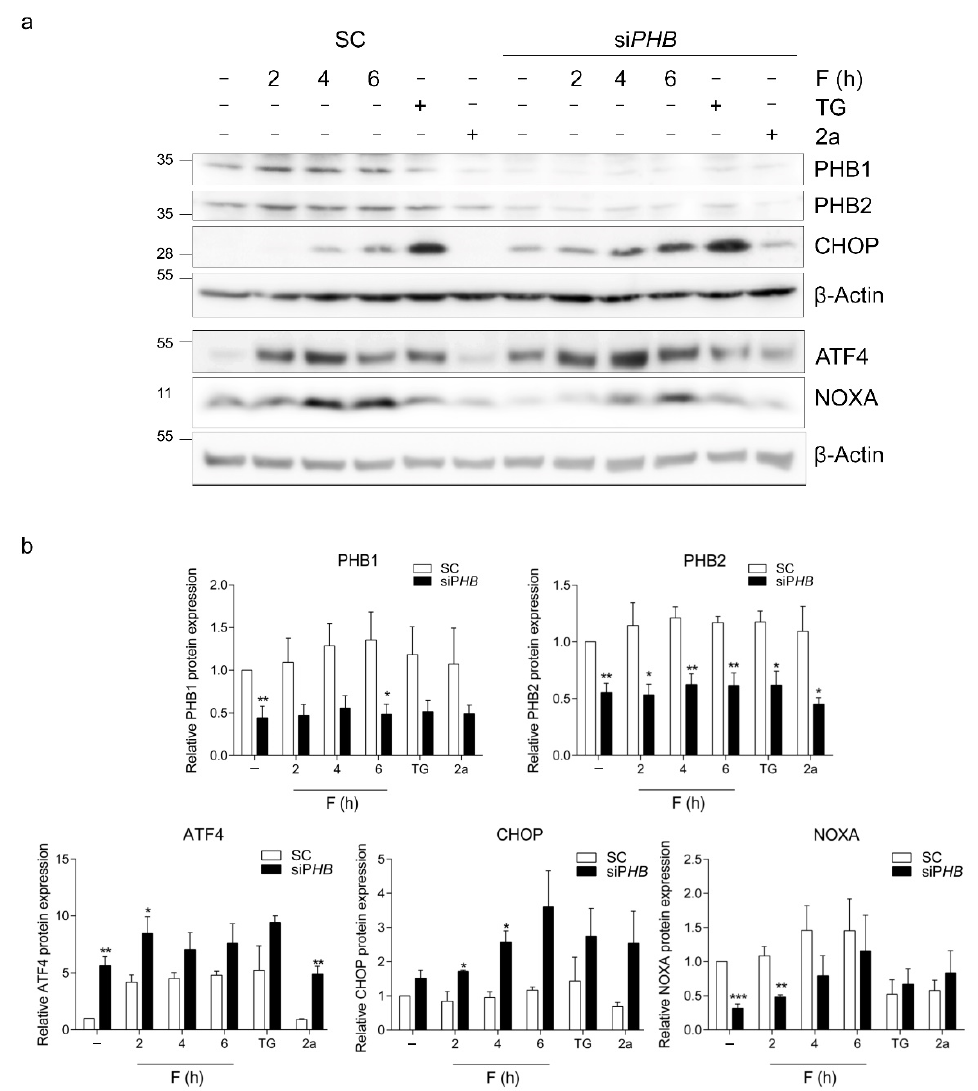
Figure 2. PHB downregulation activates the ISR. HEK293T cells were transfected with scramble (SC) or siRNA against PHB1 and PHB2 (si PHB ) for 72 h. Afterward, cells were treated either with 15 µ M fluorizoline (F) for the indicated times, with 20 µ M thapsigargin (TG) for 6 h or with 15 µ M compound 2a for 6 h. ( a ) Protein levels were analyzed by Western blot. β -actin was used as a loading control. Images proceeding from different gels are separated with white space. These are representative images of at least three independent experiments. ( b ) Quantification of relative band intensity. * p < 0.05, ** p < 0.01, *** p < 0.001. Each condition vs. SC ( n = 3).